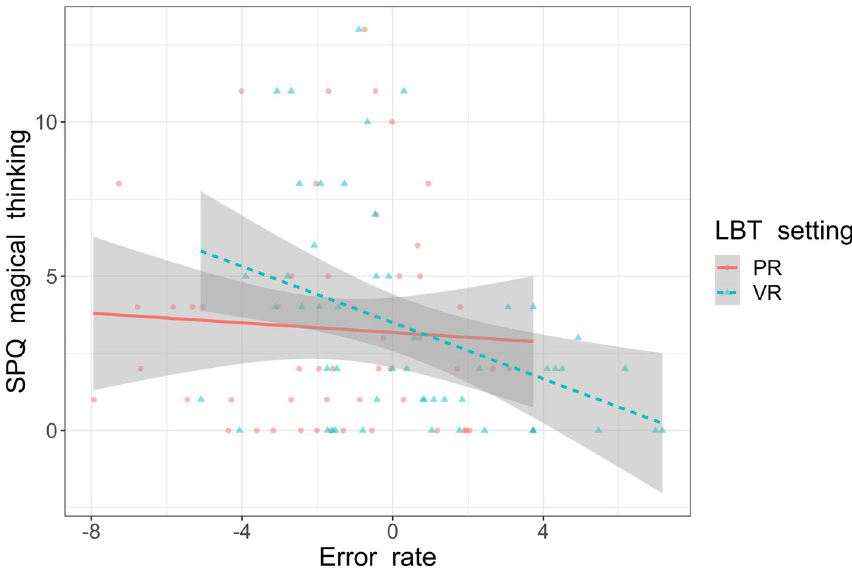
Figure 4. The association between LBT error rates in PR (continuous line) and VR (dashed line) settings and the magical thinking subscale of SPQ-BR. The “0” indicates centre of the line. The negative scores indicate leftward LBT error bias and positive scores indicate rightward LBT error